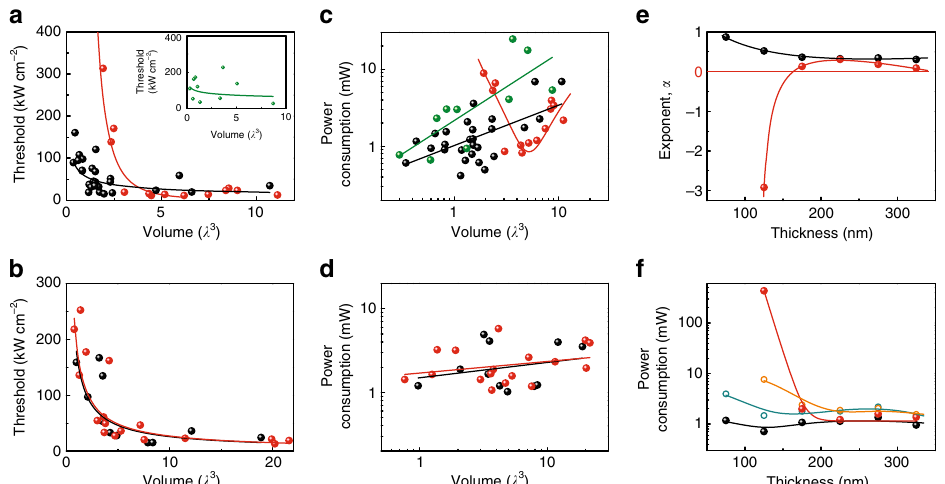
Fig. 4 Scaling laws of threshold and power consumption vs. device sizes. a , b Laser threshold scaling as a function of device volume for plasmonic (black dots) and photonic (red dots) nanolasers with thicknesses in the range of 100 nm < T < 150 nm ( a ), and 250 nm < T < 350 nm ( b ). Inset of a : Laser threshold scaling as a function of device volume for plasmonic nanolasers with thicknesses in the range of T < 100 nm. c , d Power consumption scaling as a function of device volume for plasmonic nanolasers with thicknesses in the ranges of 100 nm < T < 150 nm (black dots) and T < 100 nm (olive dots) ( c ), and 250 nm < T < 350 nm (black dots) ( d ), and for photonic nanolasers with thicknesses in the ranges of 100 nm < T < 150 nm (red dots) ( c ), and 250nm < T < 350 nm (red dots) ( d ). Lines in a – d show exponential fi ttings to data. e , f Quantitative analysis of power consumption scaling of plasmonic and photonic nanolasers. For each range of device thickness, a phenomenological scaling law is expressed as P power ð Þ consumption at threshold and α is an exponent. e shows α vs. T , highlighting the distinct scaling of power consumption of photonic (red dots) and plasmonic lasers (black dots) near the diffraction limit. f shows the power consumption of plasmonic and photonic nanolasers at a volume of 0.5 λ 3 (black dots for plasmonic nanolasers, red dots for photonic nanolasers) and 2 λ 3 (dark cyan circles for plasmonic nanolasers, orange circles for photonic nanolasers) for varied thickness, where lines are guides to the eye. In all the panels, λ refers to 700